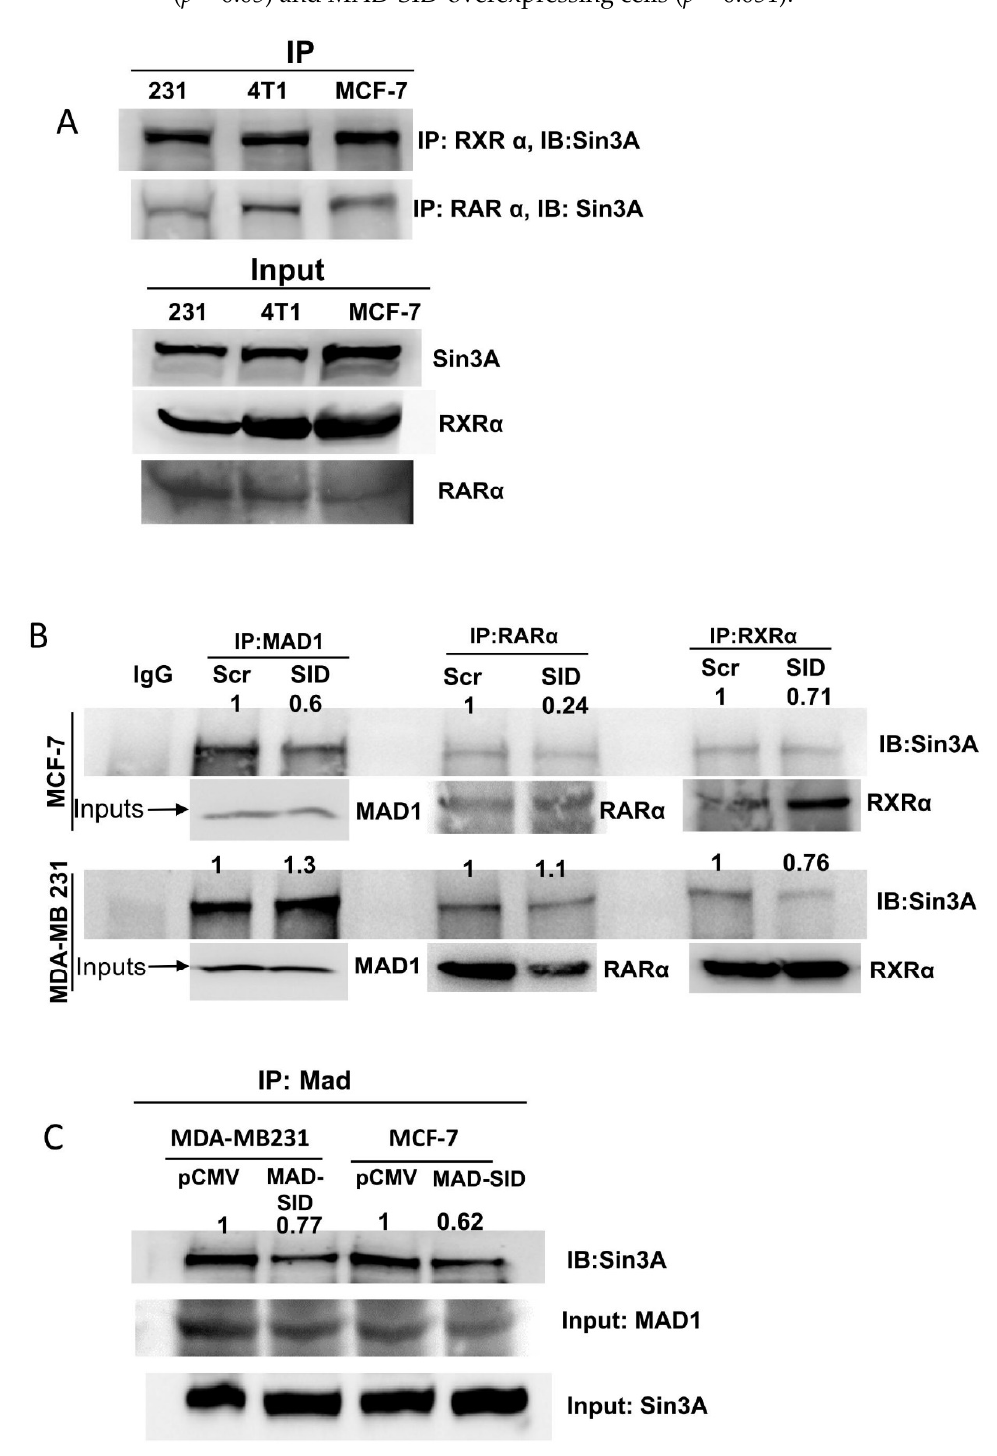
Figure 2. The MAD-SID peptide disrupts the RAR α /RXR α interaction with Sin3A: Co-precipitation experiments were performed to verify the association between RAR α , RXR α and Sin3A in breast cancer cells lines. Lysates of wild-type MDA-MB-231, 4T1 and MCF-7 were precipitated with RAR α and RXR α antibodies, and the complex was precipitated on proteinA/G beads, eluted and subjected to SDS- PAGE and Western blotting. ( A ) A co-immunoprecipitation assay showed that Sin3A